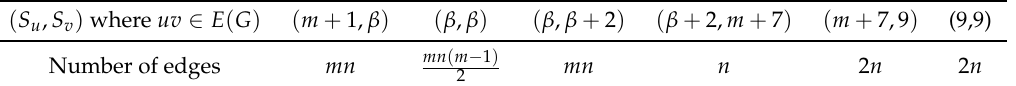
Table 7. The edge partition of the graph G .